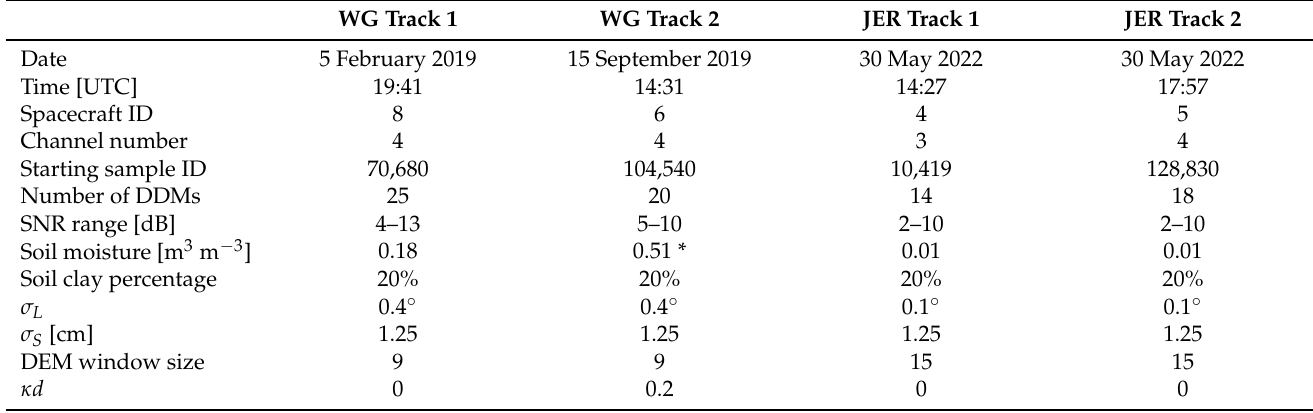
Figure 7. WG track 2 : ( a ) Track elevation map; ( b ) Peak reflectivity. The SoilSCAPE sites are between the orange vertical lines. Table 2. Analyzed track